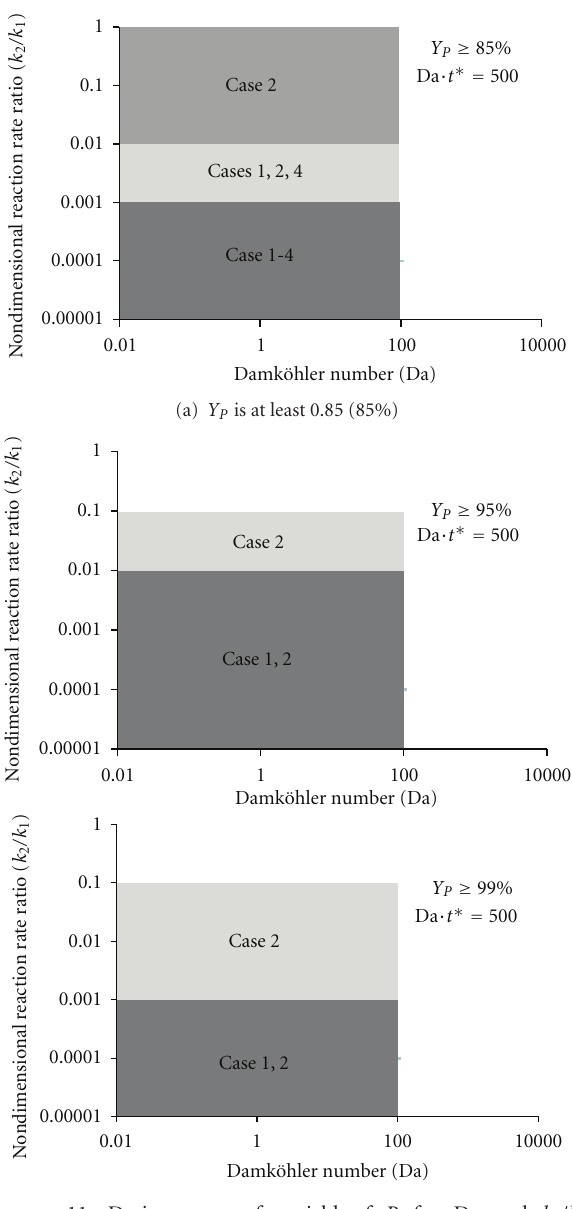
Figure 11: Design spaces for yield of P for Da and k 2 / k 1 at Da · t ∗ = 500 for C-P